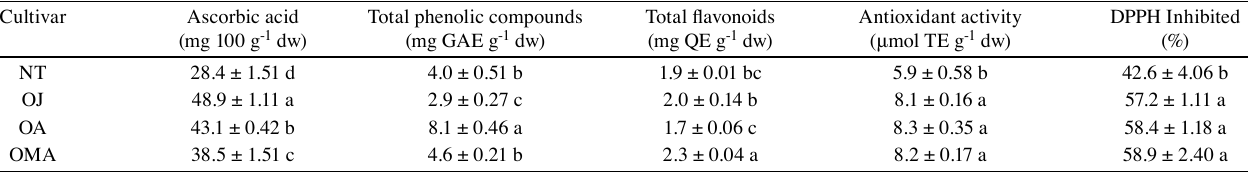
Tab. 1: Nutraceutical content and antioxidant activity of four nopal cultivars. Cultivar